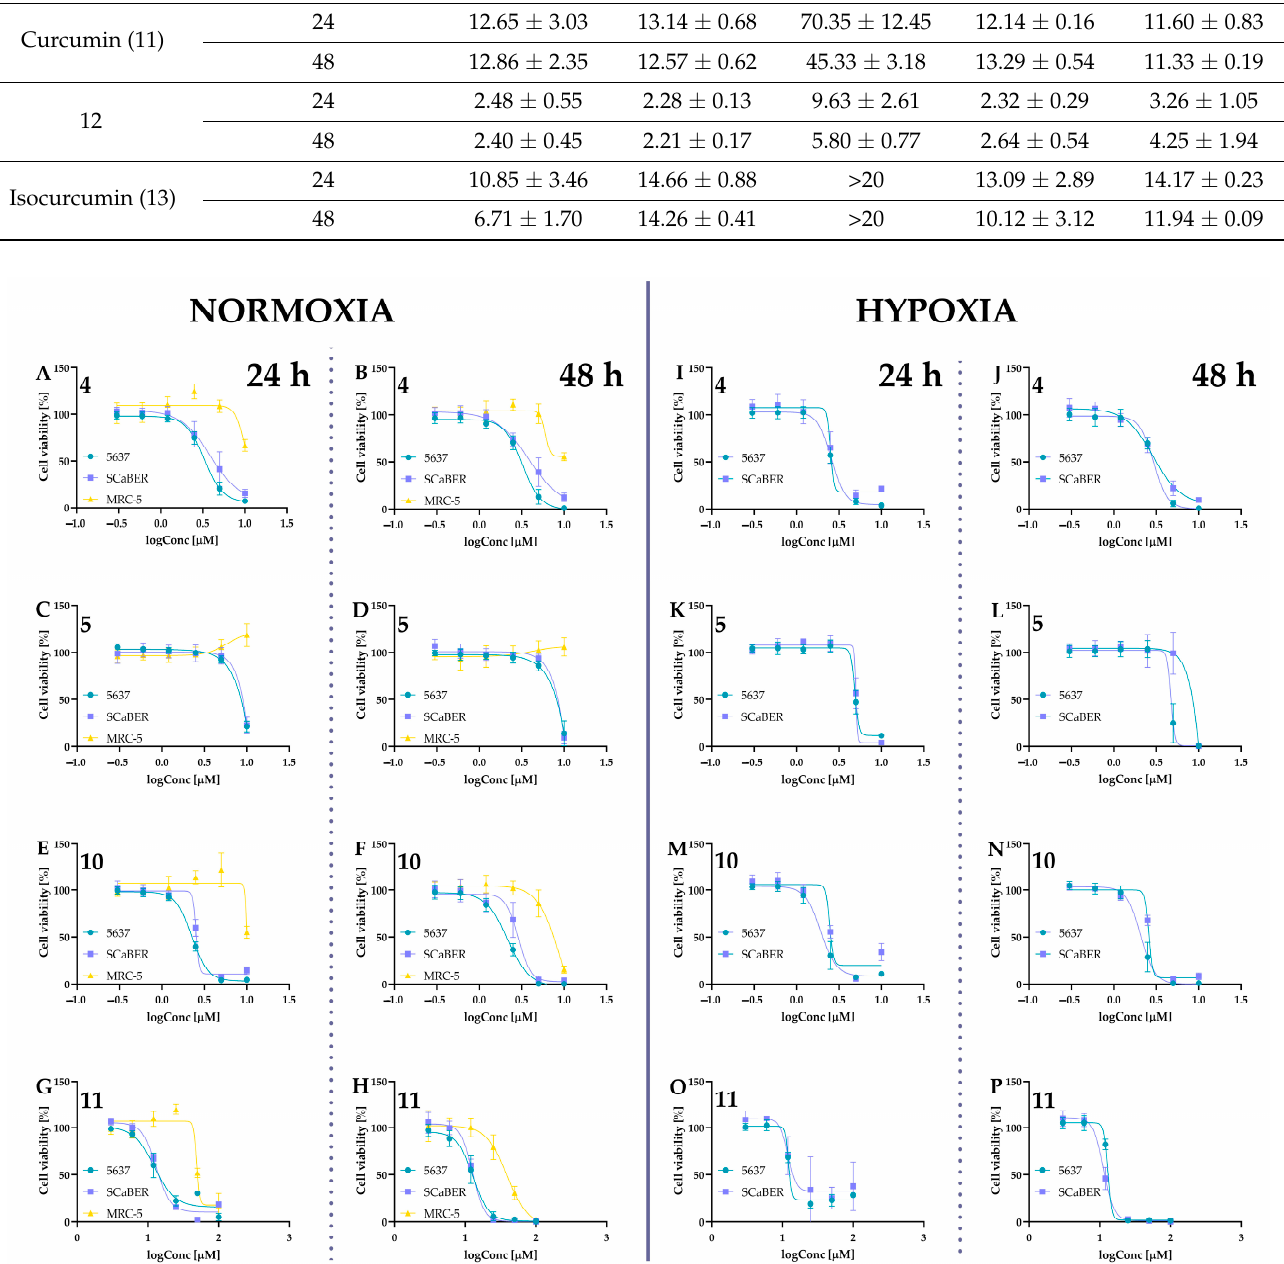
Figure 8. The cytotoxic effect of compounds 4 , 5 , 10 , and 11 on two human bladder cancer cell lines (5637, SCaBER), and a human noncancerous lung fibroblast cell line (MRC-5) under normoxic conditions and cancer cell lines also under hypoxic conditions (1% of oxygen). Panels ( A – H ) present data for normoxic conditions: panels ( A – B ) for compound 4 ; panels ( C – D ) for compound 5 ; panels ( E – F ) for compound 10 ; panels ( G – H ) for compound 11 . Panels ( I – P ) present data for hypoxic conditions: panels ( I – J ) for compound 4 ; panels ( K – L ) for compound 5 ; panels ( M – N ) for compound 10 ; panels ( O – P ) for compound 11 .Cells were treated with curcumin derivatives at a concentration